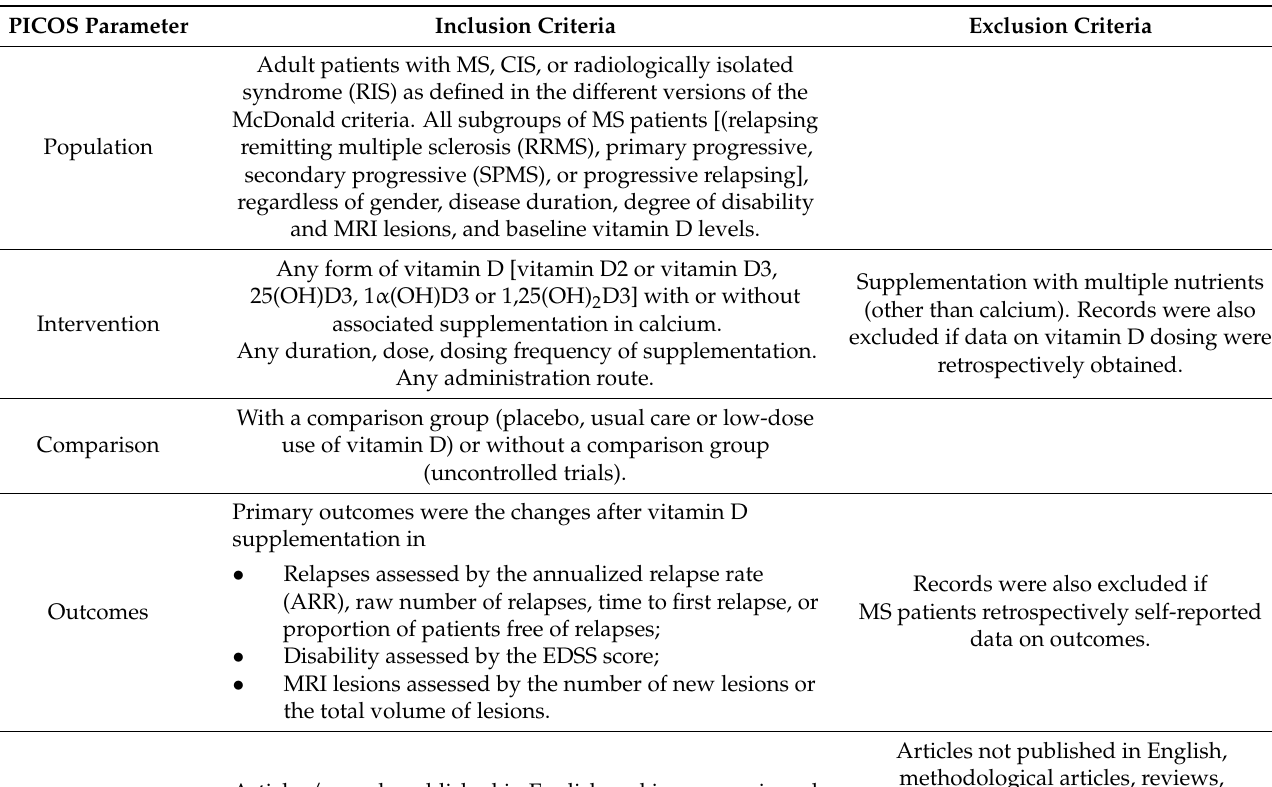
Table 1. Eligibility criteria for the selection of